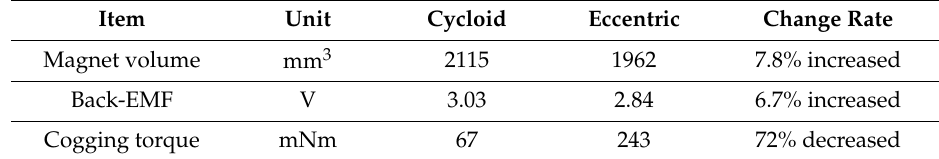
Table 7. Magnet volume, back-EMF, and cogging torque for FEA results.